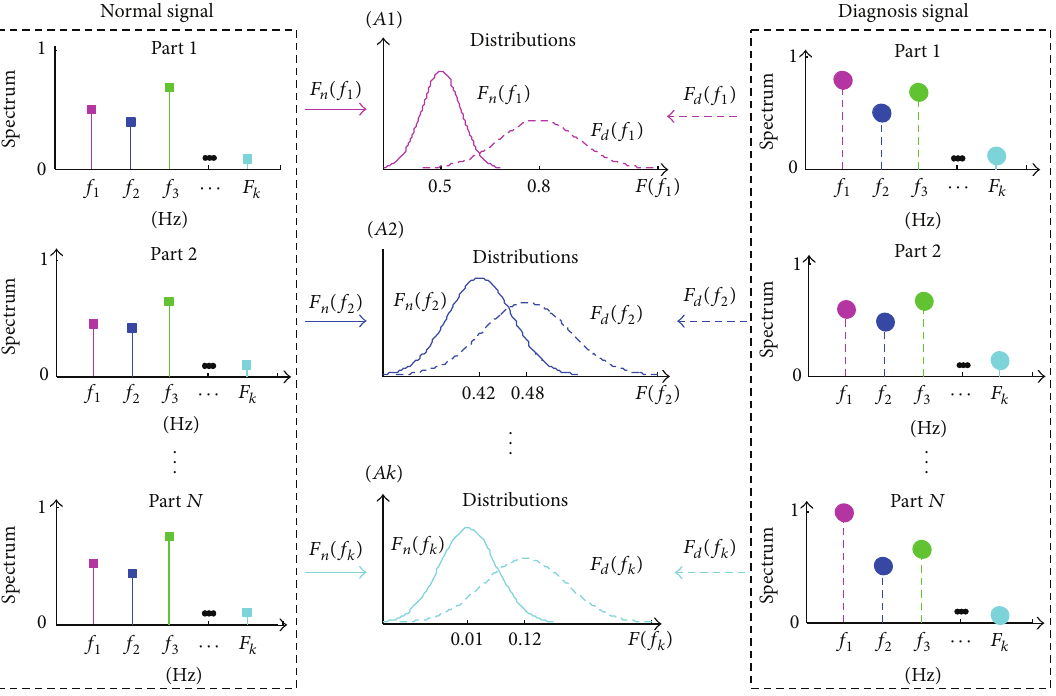
Figure 5: Spectrums of each part between normal and diagnosis signals and the normal distributions of 𝐹 𝑛 (𝑓 𝑘 ) and 𝐹 𝑑 (𝑓 𝑘 ) at the frequencies 𝑓 𝑓 1 and 2